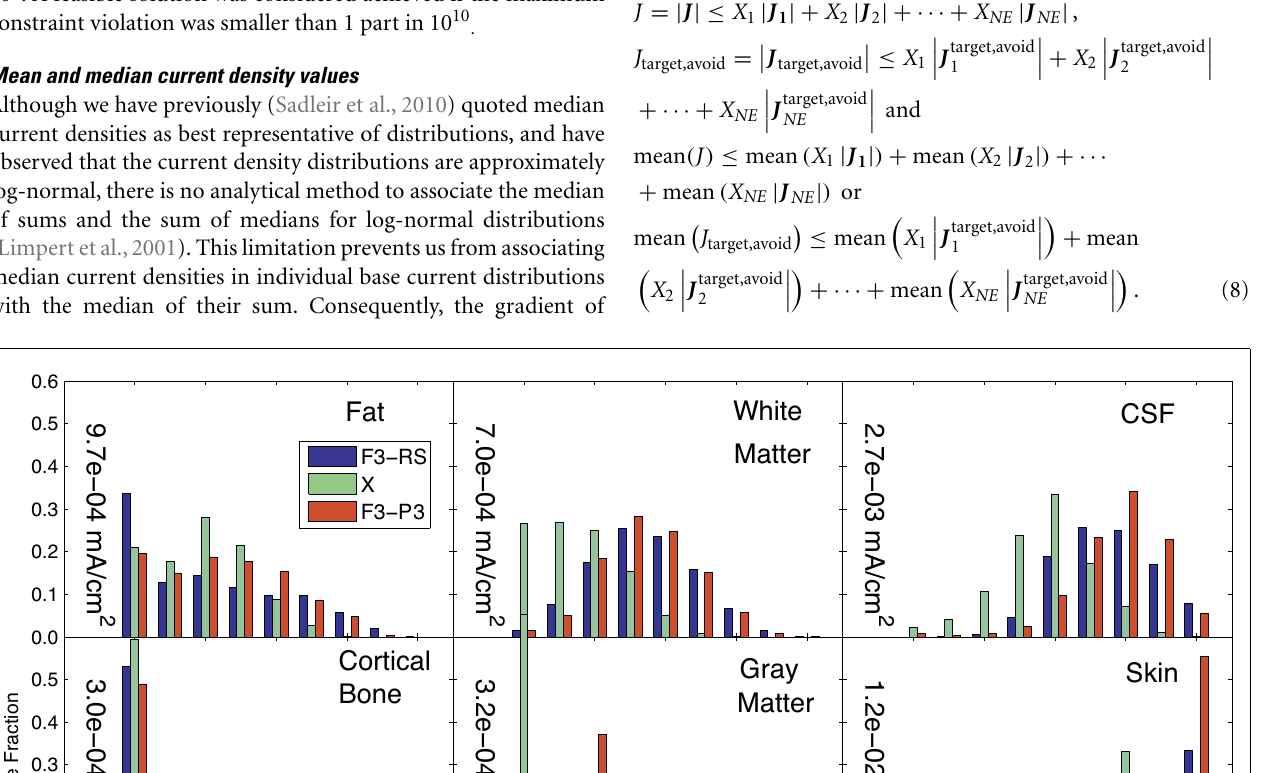
configuration formed using the two electrodes with the largest weights of X. Median values found in each tissue for the optimal solution (X) are shown within each graph of the